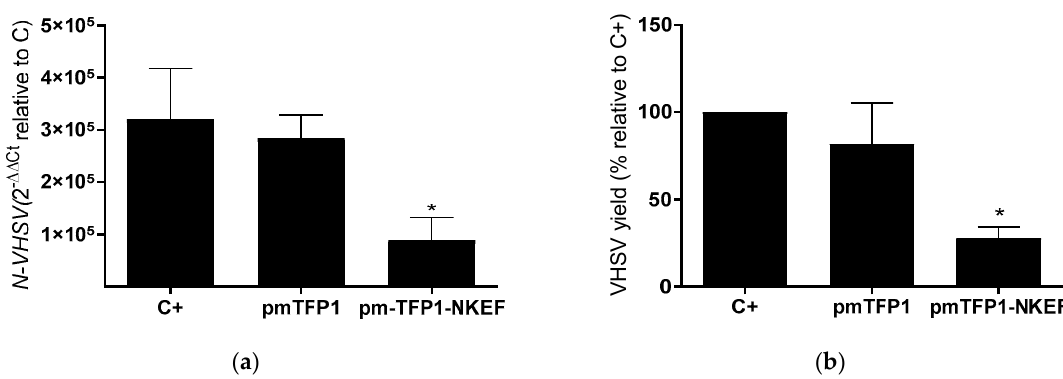
Figure 6. VHSV infectivity in EPC cells transfected with pmTFP1 ‐ NKEF. EPC cells were transfected with pmTFP1 ‐ NKEF. At 48 h post ‐ transfection, cells were exposed to VHSV MOI 0.1 for 24 h at 14 °C. Cells transfected with empty plasmid (pmTFP1) were used as a negative control. ( a ) VHSV replication in transfected EPC cells analyzed by RT ‐ qPCR of the N ‐ VHSV gene. N ‐ VHSV gene expression was normalized to uninfected cells. C arp ‐ ef1 α was used as a reference gene. C+ represents VHSV ‐ infected control and C means uninfected cells. Data represent the mean ± SD of 2 experiments. The Kruskal–Wallis test and Dunn ʹ s multiple comparison post hoc test were performed for statistical analysis. * indicates a p ‐ value < 0.05. ( b ) Evaluation of VHSV titer in the supernatant of EPC cells transfected with pmTFP1 ‐ NKEF. VHSV yield represented as percentage of virus FFU/mL relative to positive control (untransfected and infected cells, C+). Data represent the mean ± SD of two experiments. The Kruskal–Wallis test and Dunn ʹ s multiple comparison post hoc test were performed for statistical analysis. * indicates a p ‐ value < 0.05.